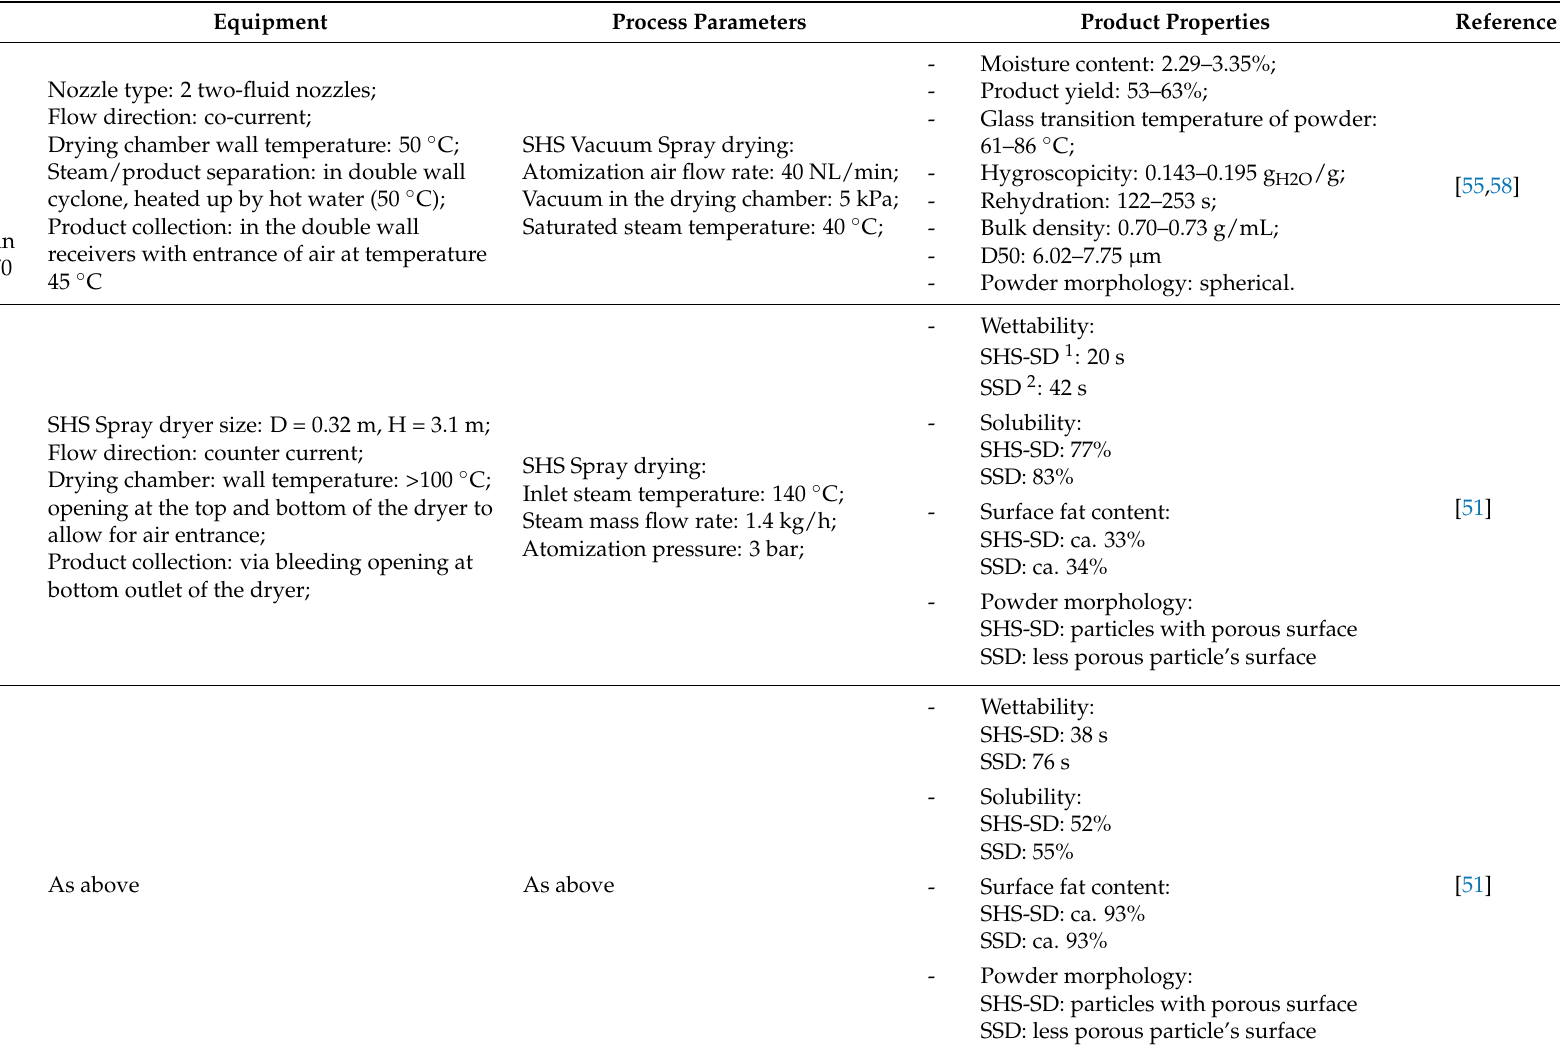
Table 1. SHS spray drying in the laboratory and pilot plant